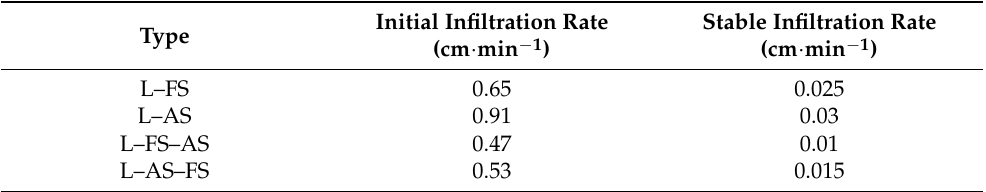
Figure 3. Variation process of vertical water infiltration rate. Table 2. Characteristic parameters of vertical infiltration rate of water of different types of loess ‐ sandstone structure.